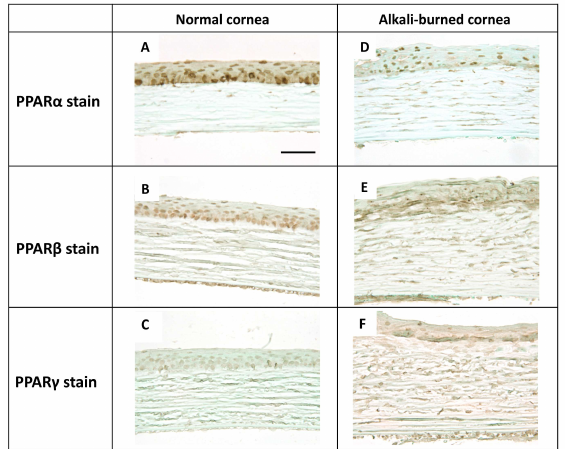
Figure 1. The expression of peroxisome proliferator-activated receptors (PPARs) in rat normal cornea and alkali-burned cornea at day 7. PPARα-, β-, and γ-positive cells were observed in the epithelial basement cells of normal cornea (center). ( A – C ; A : PPARα stain, B : PPARβ stain, C : PPARγ stain). In the alkali-burned cornea at day 7, PPARα, β, and γ was expressed on the re-epithelialized basement cells ( D – F ; D : PPARα stain, E : PPARβ stain, F : PPARγ stain). Scale bar: 40 μm.